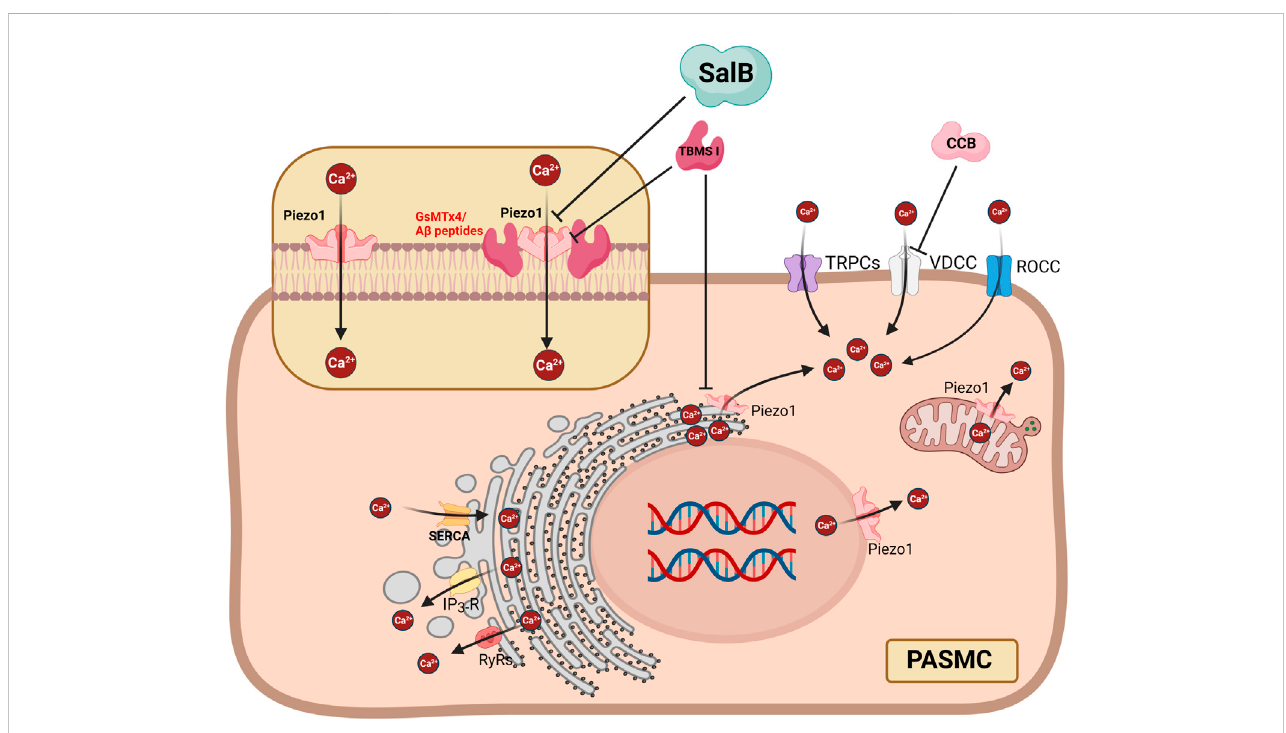
FIGURE 1 Proposed mechanisms showing that inhibition of Piezo1 in PASMC can suppress Ca 2+ in fl ux and release from subcellular organelles, as well as Ca 2+ fl ow mediated by other Ca 2+ channels. SalB can inhibit extracellular Ca 2+ in fl ux through the PM localized Piezo1 but not subcellular organelles. GsMTx4 and A β peptides inhibit Piezo1 by changing the structure of the membrane. TBSM I suppresses PM localized Piezo1 and subcellular organelles localized Piezo1. ER = Endoplasmic Reticulum; IP3R = inositol 1,4,5-trisphosphate receptors; PASMC = pulmonary artery smooth muscle cell; PM = plasma membrane; ROCC = receptor-operated Ca 2+ channels; RyRs = ryanodine receptors; SalB = Salvianolic Acid B; SERCA = sarcoplasmic reticulum Ca [2+]-ATPase; SR = Sarcoplasmic Reticulum; VDCC = voltage-dependent calcium channels. The fi ure is created with